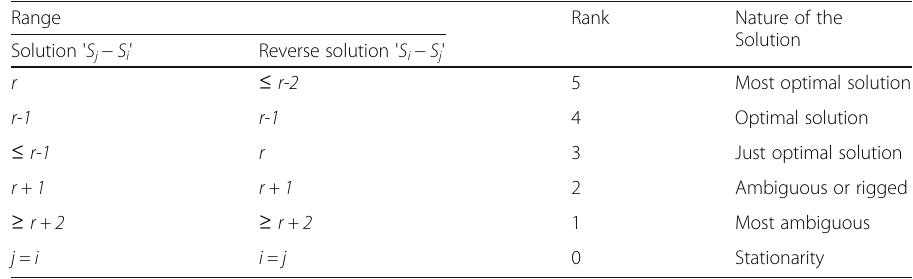
Table 2 Range, rank and nature of the solution